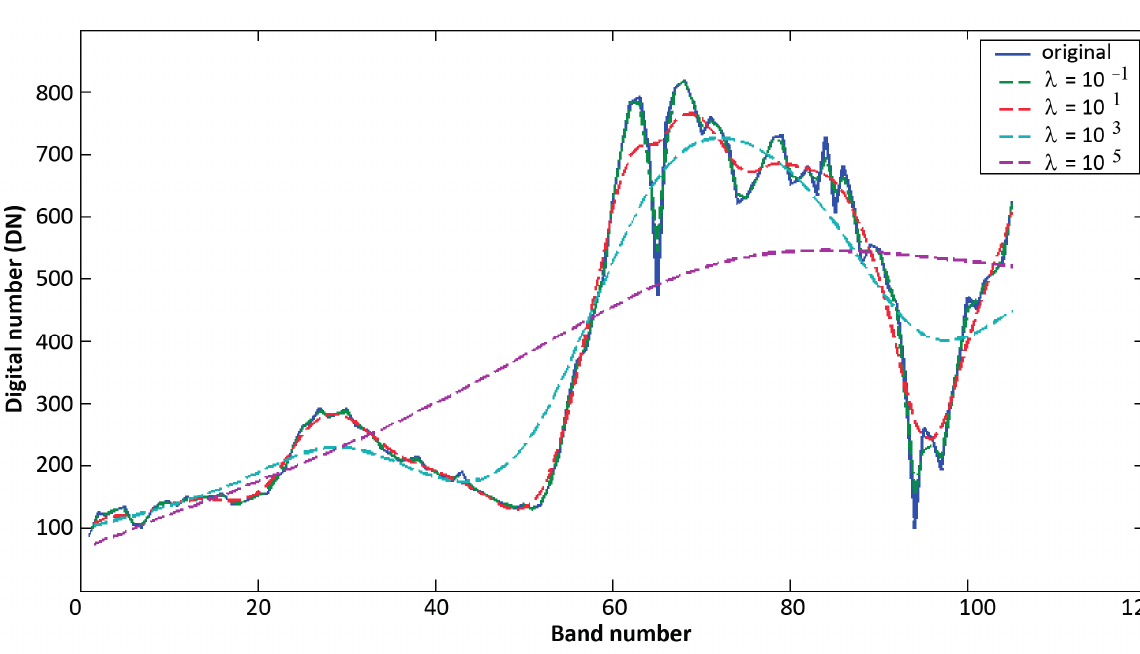
Figure 4. Effect of ARCTIS’s smoothing parameter ( λ ) on the roughness of the smoothed curve. The parameter can be varied using a slider until a visually pleasant result is found. The graph shows the original (noisy) spectra (in blue), as well as four results obtained with strongly varying λ . The original band numbers are kept for the x-axis.